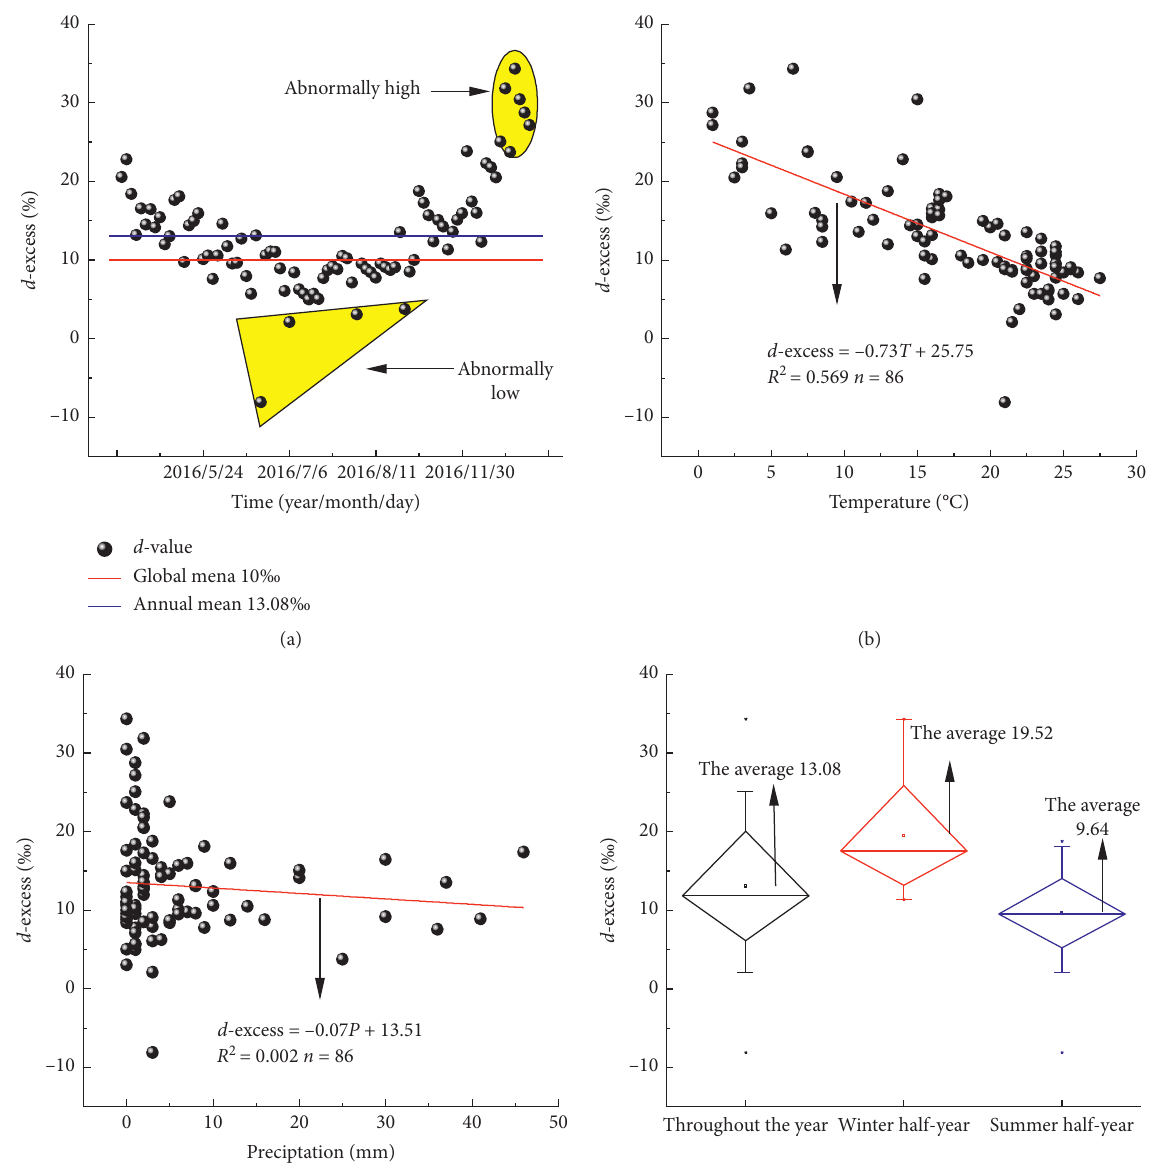
Figure 3: Variations of d -excess in precipitation in the Guanling